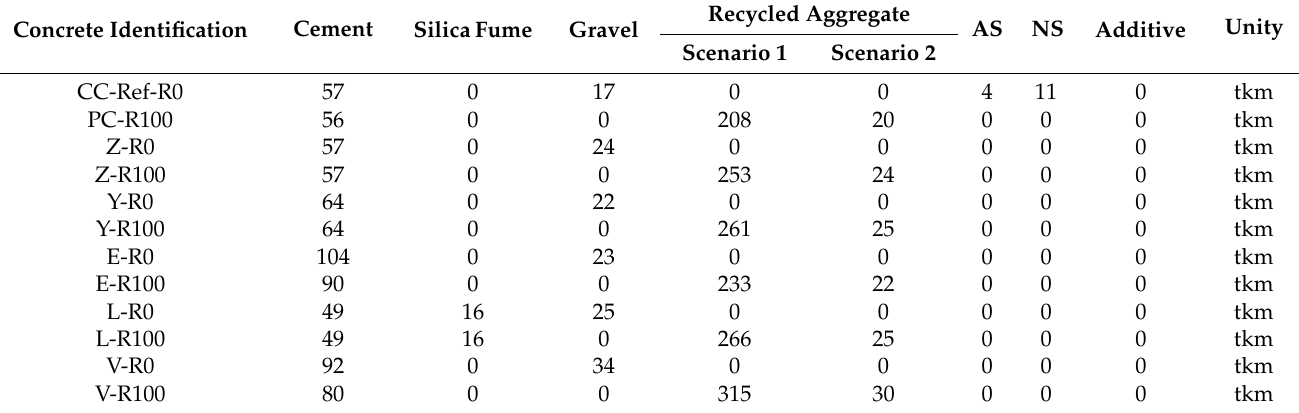
Table 6. Results of the transportation inventory for each concrete mix (figures per m 3 of produced concrete). Concrete Identification Cement Silica Fume Gravel